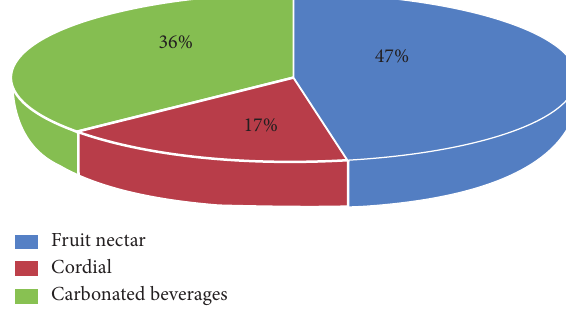
Figure 1: Consumer preference of beverages.